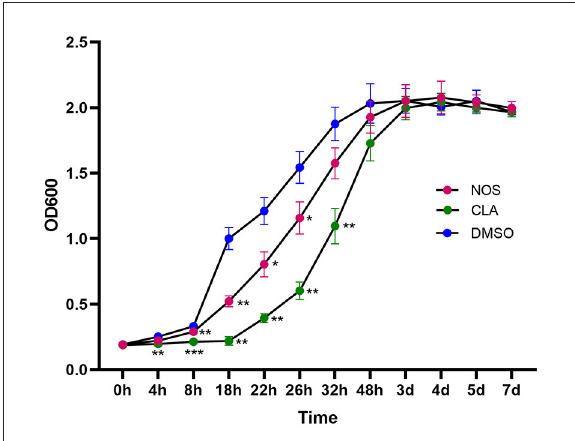
FIGURE4 Post-antibiotic effect (PAE) in the growth of M. abscessus ATCC19977 after pulse dosing with NOS and CLA. CLA was used as a positive control and DMSO as a negative control. All data are shown as the means ± SD ( n = 3). NOS vs. DMSO. * P < 0.05; ** P < 0.01; *** P < 0.001.